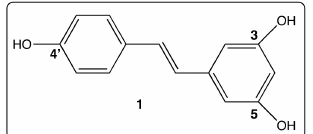
Figure 1. Structure of trans -Resveratrol ( 1